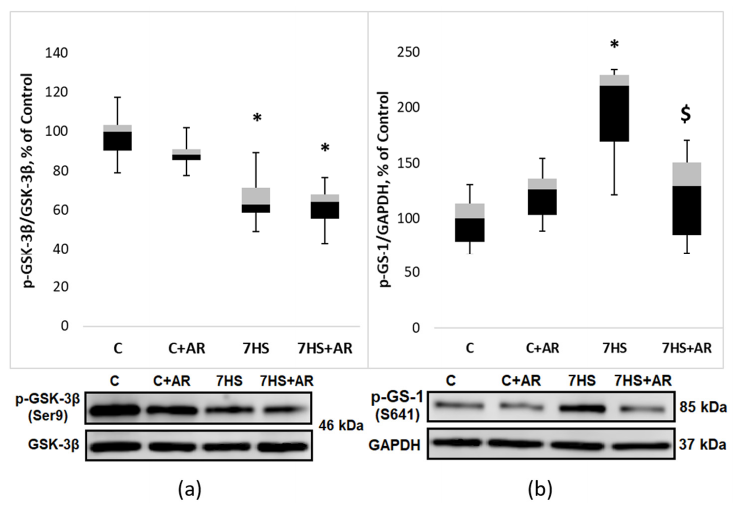
Figure 2. Effect of GSK-3 inhibition during 7-day unloading on GSK-3 β Ser9 phosphorylation ( a ) and GS-1 Ser 641 phosphorylation ( b ) in rat soleus muscle. Data are presented as median, interquartile range, minimum and maximum values, expressed as % of control. C, vivarium control group, C + AR, vivarium control rats + daily injections of GSK-3 inhibitor (AR-A014418) for 7 days, 7HS, hindlimb suspension for 7 days, 7HS + AR, 7-day hindlimb suspension + daily injections of GSK-3 inhibitor (AR-A014418), *: p < 0.05 vs. C, $: p < 0.05 vs. 7HS.